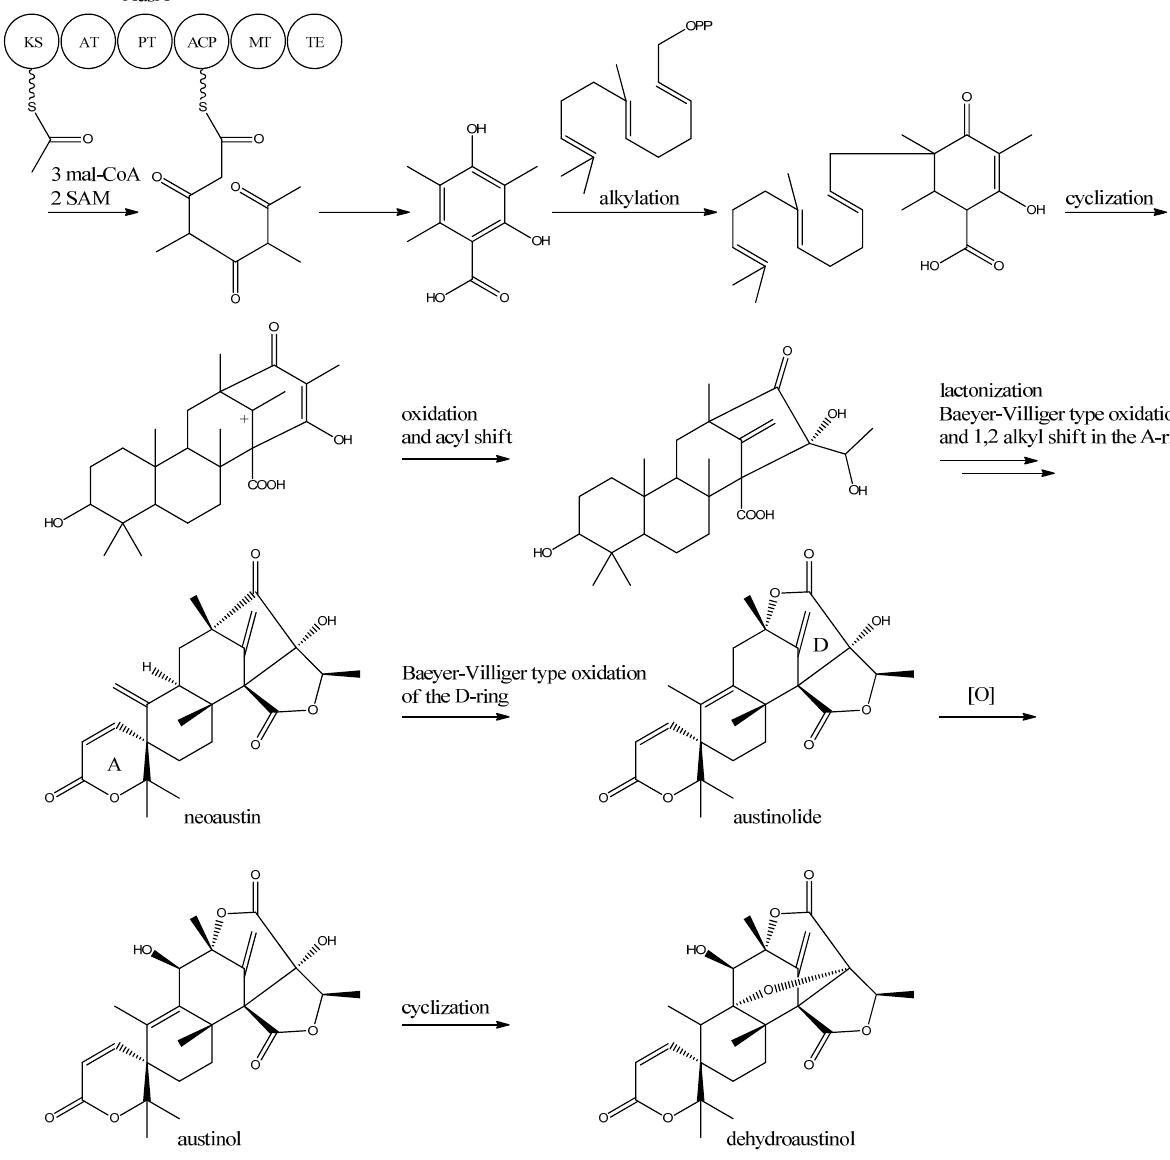
Figure 13. Proposed biosynthesis of austinol and dehydroaustinol. All genes in the biosynthesis of austinol and dehydroaustinol, except AusA, are